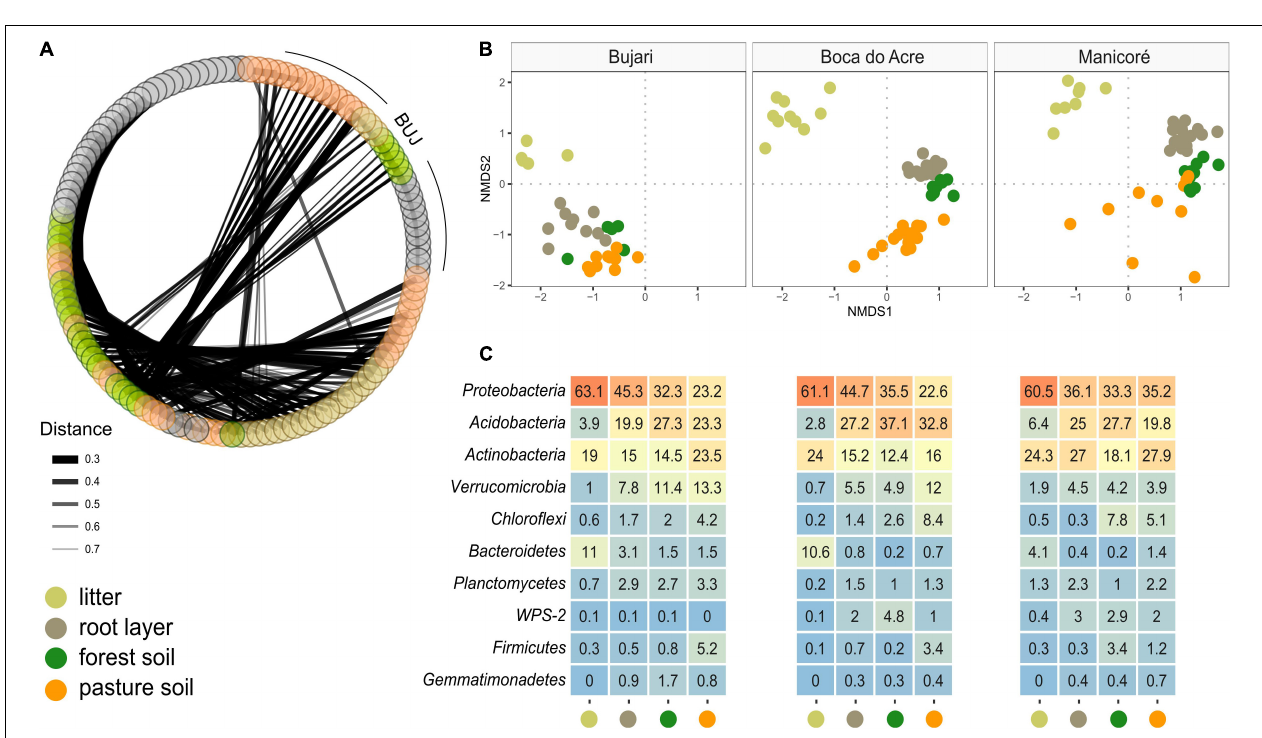
FIGURE 2 | Land-use and soil type shape prokaryotic metacommunity structure in the bulk soils. (A) Non-metric multidimensional scaling (NMDS) based on Bray–Curtis dissimilarity among samples in the normalized ASV data of soil prokaryotic communities, highlighting the study sites and soil variables correlated with community structure; (B) NMDS (Bray–Curtis dissimilarity) of prokaryotic soil communities of each study area, highlighting the sample distribution pattern by land-use (upper boxes) and gradient of fertility (below boxes, by the base saturation index).